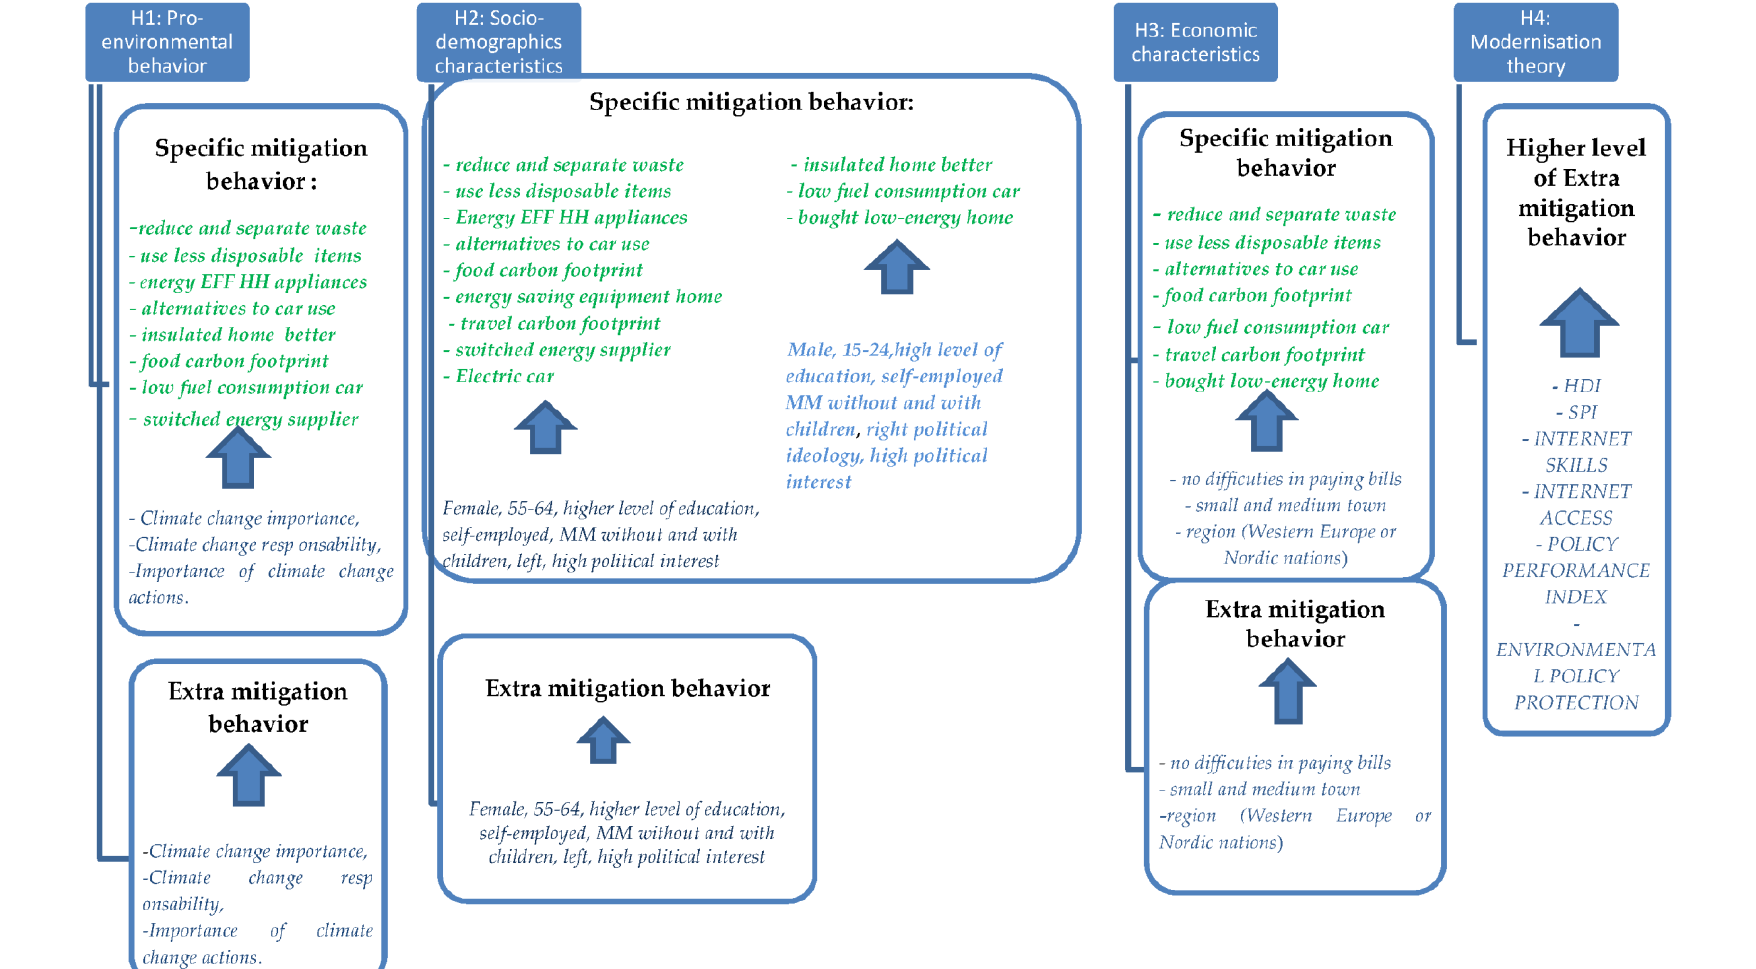
Figure 6. Summary of findings in relation to specific mitigation and extra mitigation behavior.